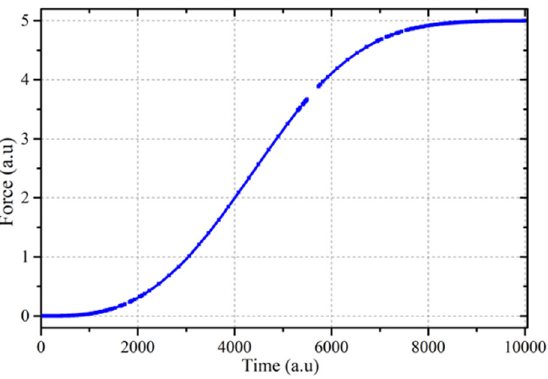
Figure 4. Force as a function of time for a GeTe film modelled using Equation (7) and an exponentially increasing time-dependent viscosity.